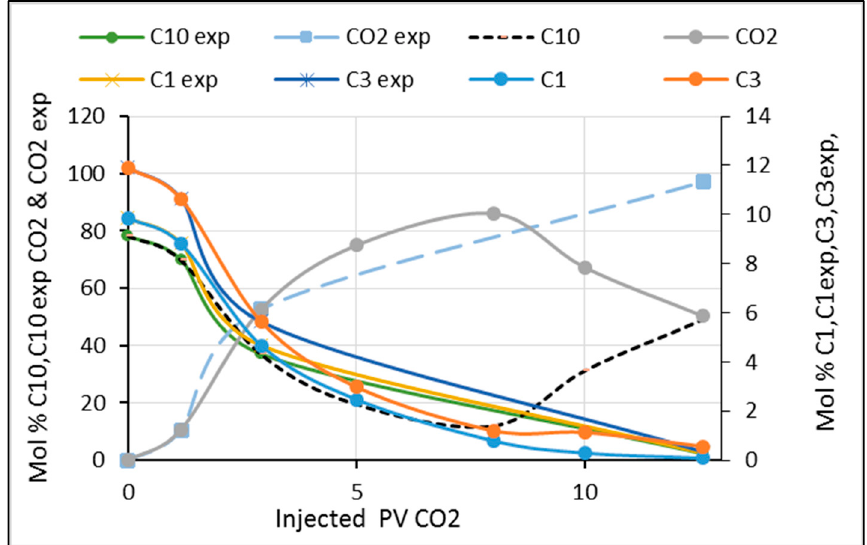
Figure 5. Dynamic changes in the composition in the liquid phase as a function of the injected pore volume (PV) for live Oil B (78.23 mole % n-C10/9.86 mole % C1/11.9 mole % C3) flooded with CO 2 .